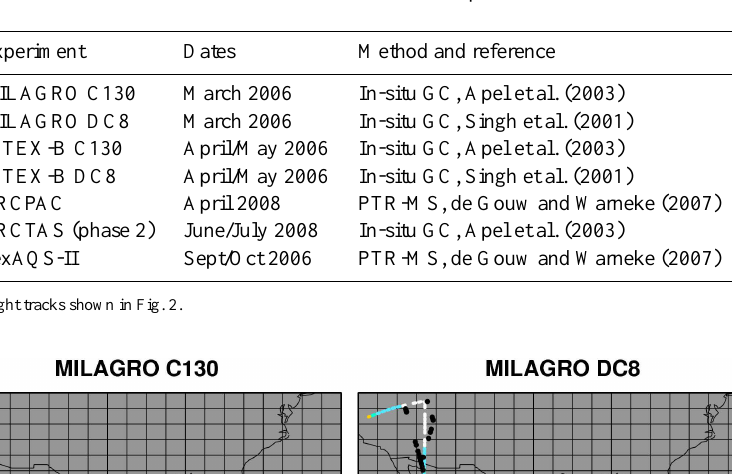
Table 1. Aircraft measurements of methanol used for evaluation of TES and IASI space-based retrievals 1 .